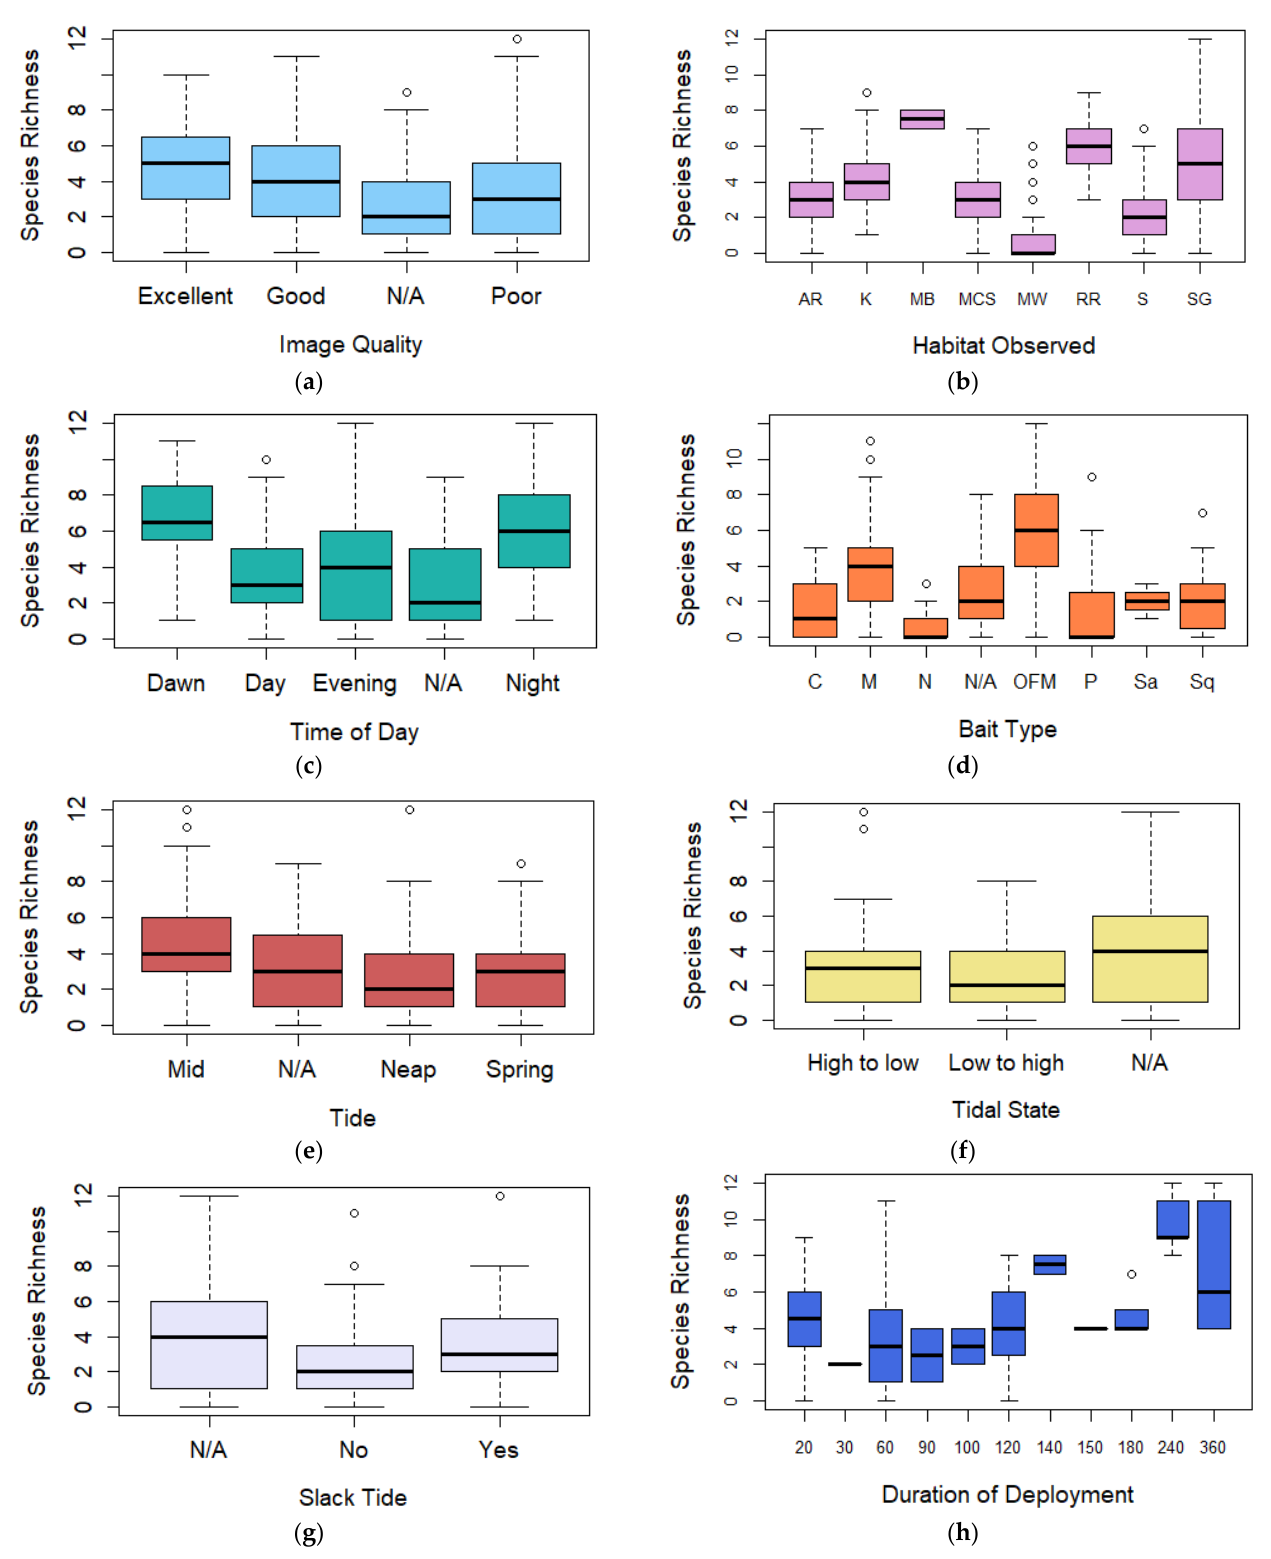
Figure 3. Boxplot (box ranging from first to third quartile and highlighting median value, whiskers extending to 1.5 the interquartile distance with circles indicating outliers) comparing species richness for ( a ) image quality, ( b ) broad habitat observed, ( c ) time of day, ( d ) bait type, ( e ) spring/neap tides, ( f ) tidal state, ( g ) slack tide, and ( h ) duration of deployment. AR = Artificial Reef, K = Kelp, MB = Mussel Beds, MCS = Mixed Coarse Sediment, MW = Midwater, RR = Rocky Reef, S = Sand, SG = Seagrass, C = Crab, M = Mackerel, OFM = Oily fish meal and fish oils, N = No bait, P = Prawn, Sa = Sardines, and Sq =